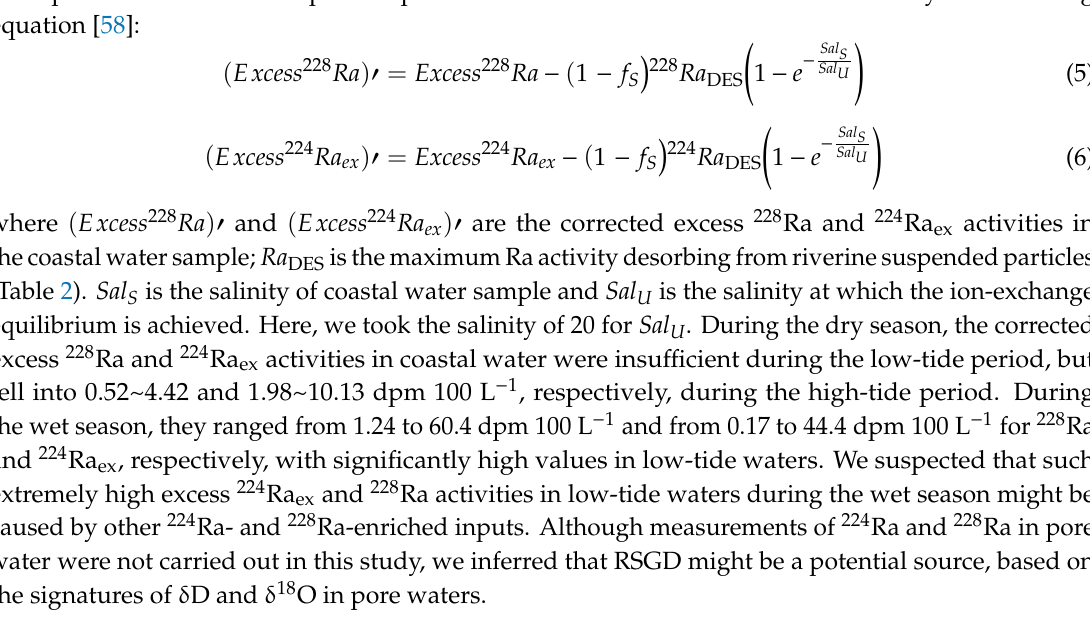
Table 2. Calculation of the maximum desorption of 224 Ra and 228 Ra from riverine suspended particles. Item 224